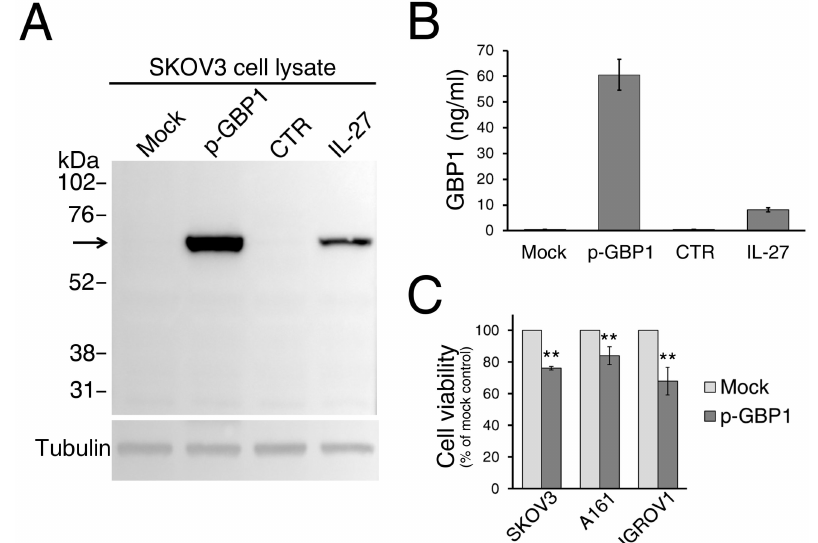
Figure 7. GBP1 gene transfer in EOC cells is su ffi cient to induce GBP1 secretion and results in decreased cell viability. ( A ) Western blot analysis of GBP1 expression in cell lysates from SKOV3 cells transfected with vector control (mock) or GBP1-pcDNA3.1 plasmid (p-GBP1). Untreated (CTR) and